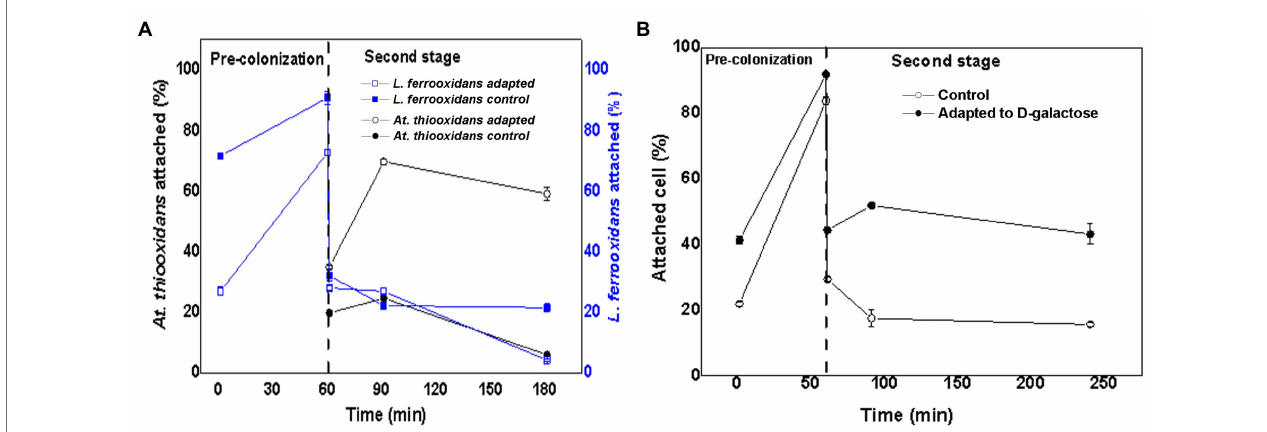
FIGURE 5 | Attachment percentage to the mineral over time of L. ferrooxidans DSM 2705 T and At. thiooxidans DSM 2705 T using L. ferrooxidans DSM 2705 T as a pre-colonizer. (A) Data obtained by qPCR. (B) Data obtained by counting total planktonic cells using a Neubauer chamber. Measurements after 1, 60, 61, 91, and 181 min of inoculation of the first species. The data correspond to the mean values of triplicates ± SD ( n = 6).